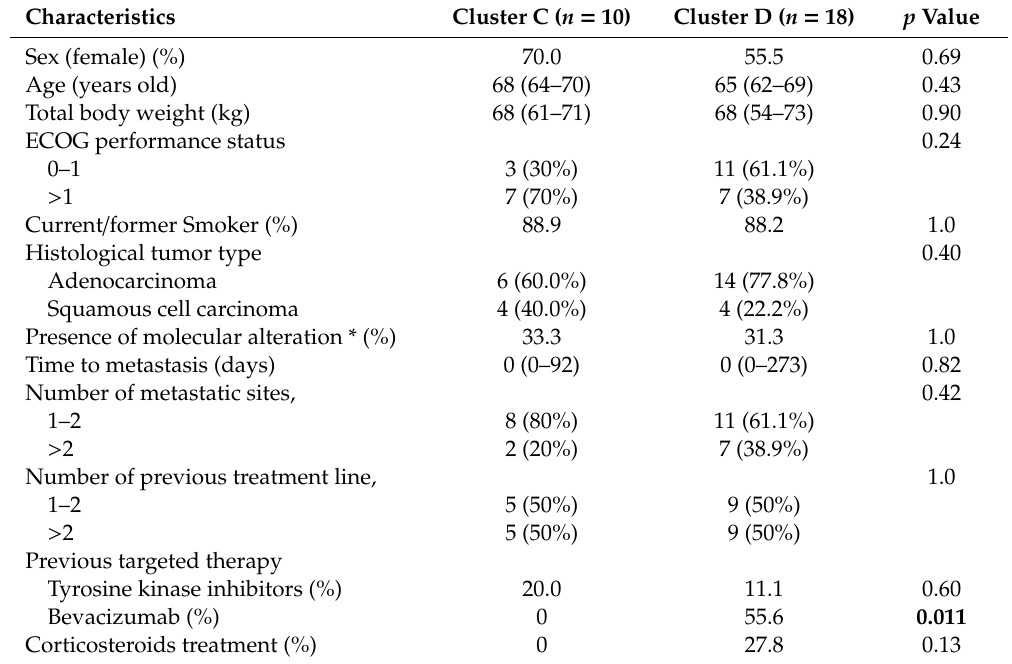
Figure 3. Inhibition profiles in PBMC from non-small-cell lung cancer patients under nivolumab therapy. Unsupervised hierarchical clustering, using Log fold change (LFC) values (Log 2 Signal (D14) − Log 2 Signal (D0)) of 80 STK substrates ( Y -axis), separates NSCLC samples ( n = 28) in two major clusters. Red color represents a low inhibition level, whereas blue corresponds to a strong inhibition. Table 3. Characteristics of the two clusters C and D of non-small-cell lung cancer patients identified after a single administration of nivolumab (14 days after treatment